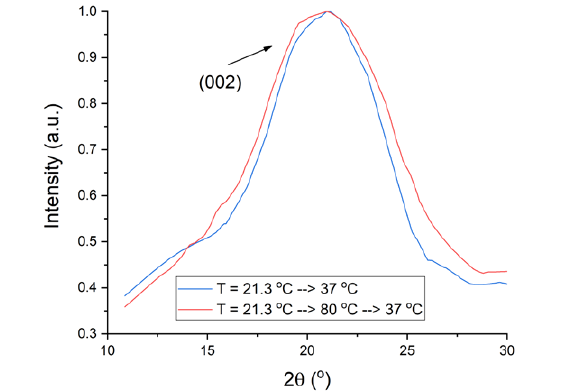
Figure 10. XRD patterns in the 2θ = 10 – 30 o range for gelatin powders gelled at 37 o C using the initially cold water heated to 37 o C (T = 21.3 o C → 37 o C) and the water preheated to 80 o C and then